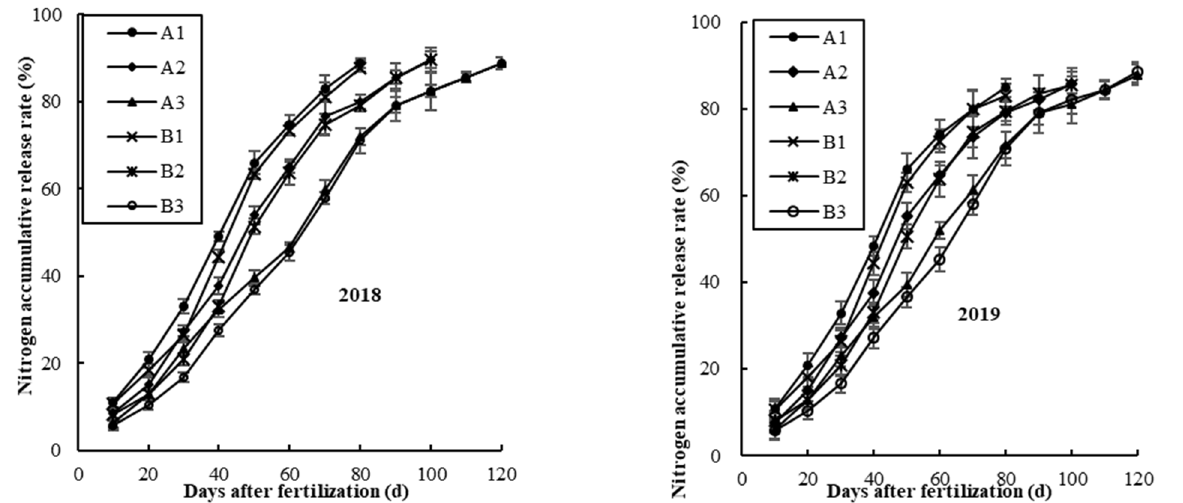
Figure 1. Cumulative nitrogen release rates of CRNF in 2018 and